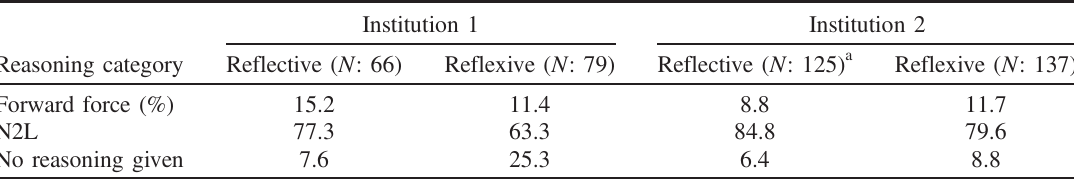
TABLE IV. Percentage of correct student responses to the target question (Q3) that fell into each reasoning category. The majority of correct responses were accompanied by correct reasoning.